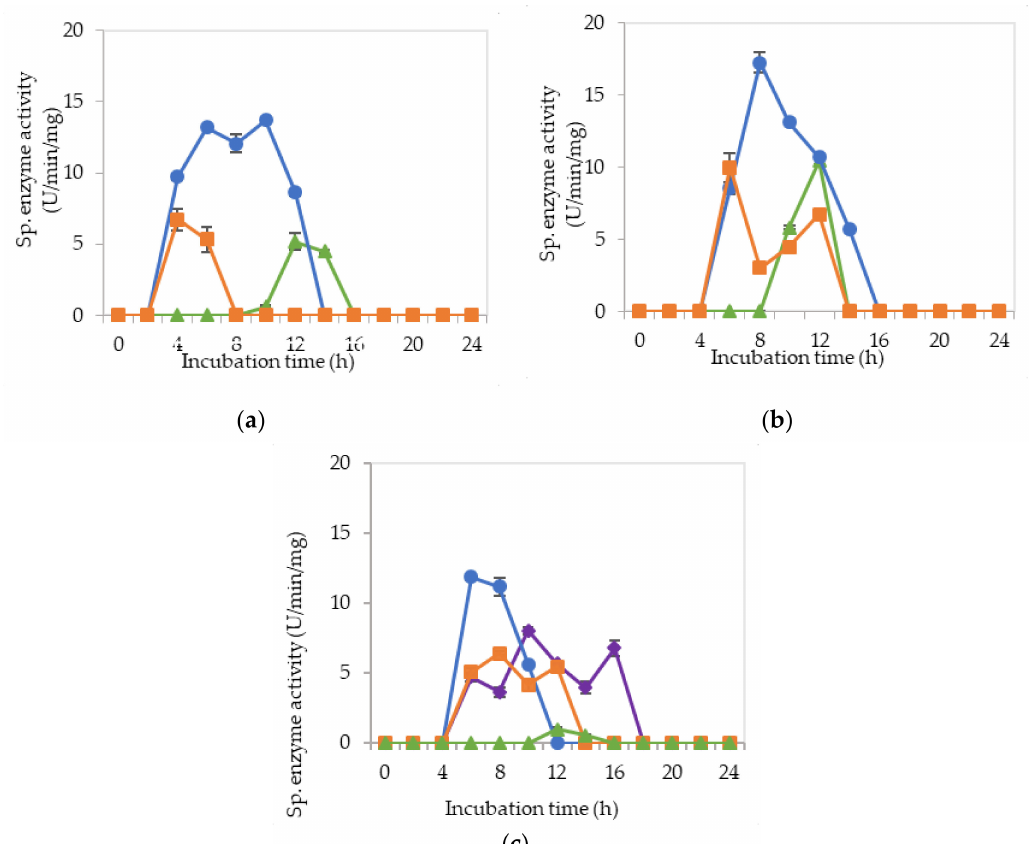
Figure 5. Specific extracellular cellulolytic and hemicellulolytic activities; ( • ) endoglucanase; ( (cid:4) ) exoglucanase; ( (cid:78) ) β -glucosidase and ( (cid:7) ) mannanase of Lactobacillus plantarum RI 11 grown in M3 (molasses and yeast extract) for 24 h. The enzyme activities were detected at three di ff erent pH levels: ( a ) pH 5; ( b ) pH 6.5; ( c ) pH 8. The error bars represent the standard deviation of specific enzyme activity of triplicate samples ( n =